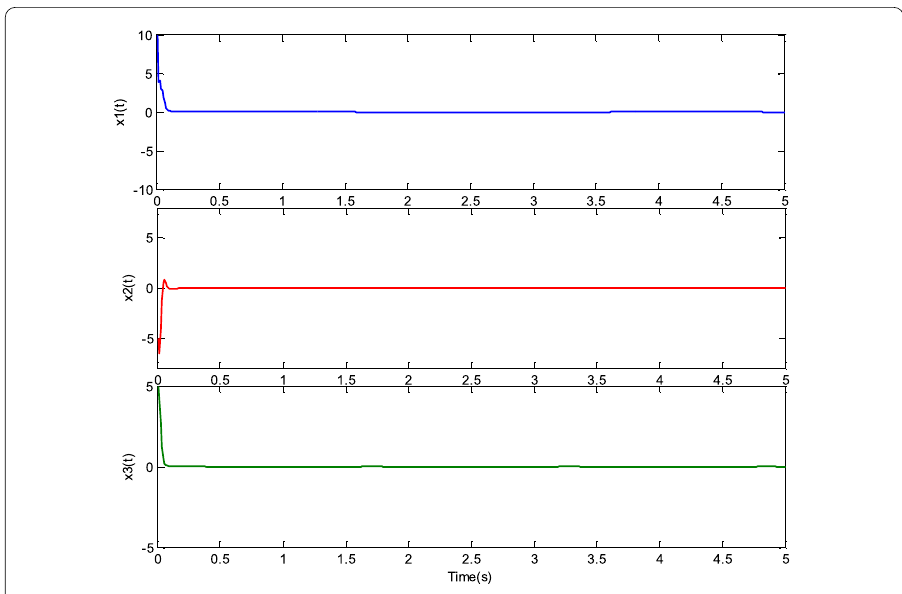
Figure 4 Closed-loop system states after applying the controller